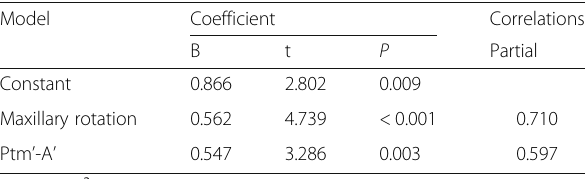
Table 2 Multiple linear regression analysis of the influence